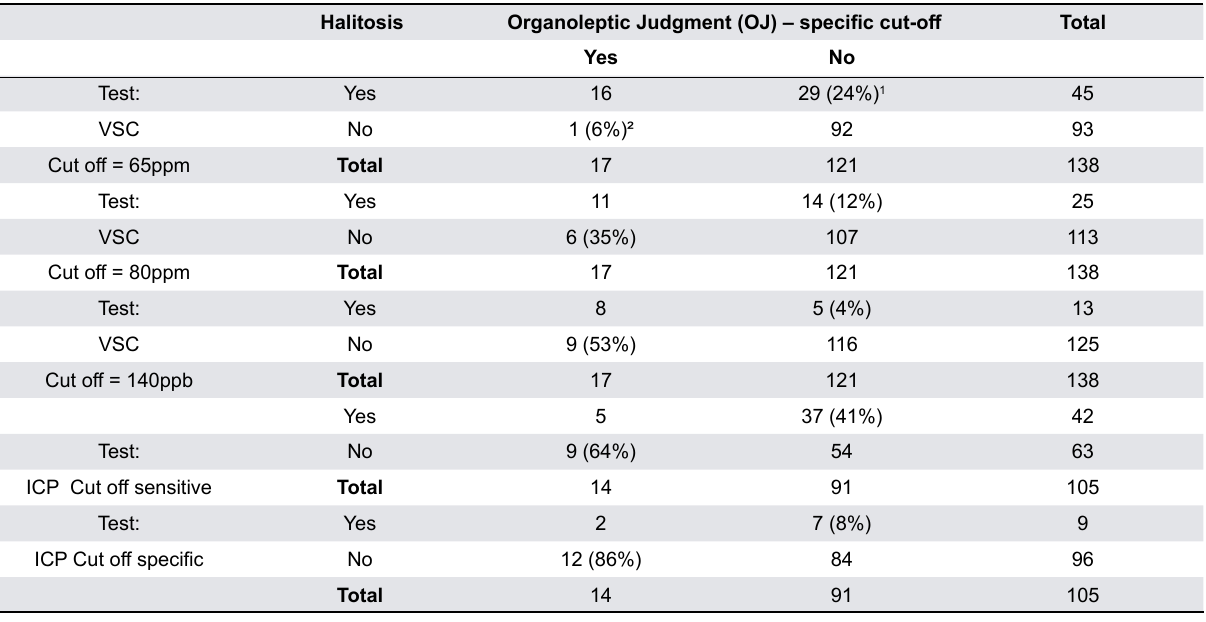
Table 2- Distribution of volatile sulfur compounds (VSC) scores and information from a close person (ICP) compared to organoleptic judgment by a trained professional (OA) at the specific cut-off point (i.e. bad breath means very severe or severe